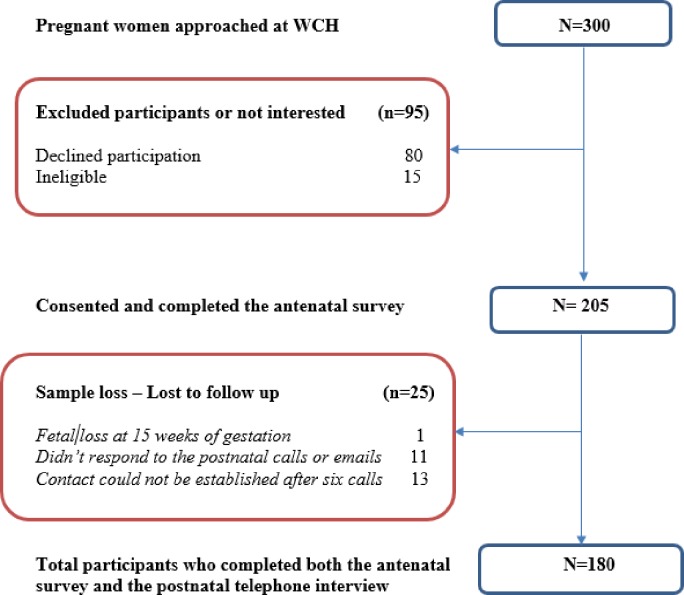
Recruitment flowchart.